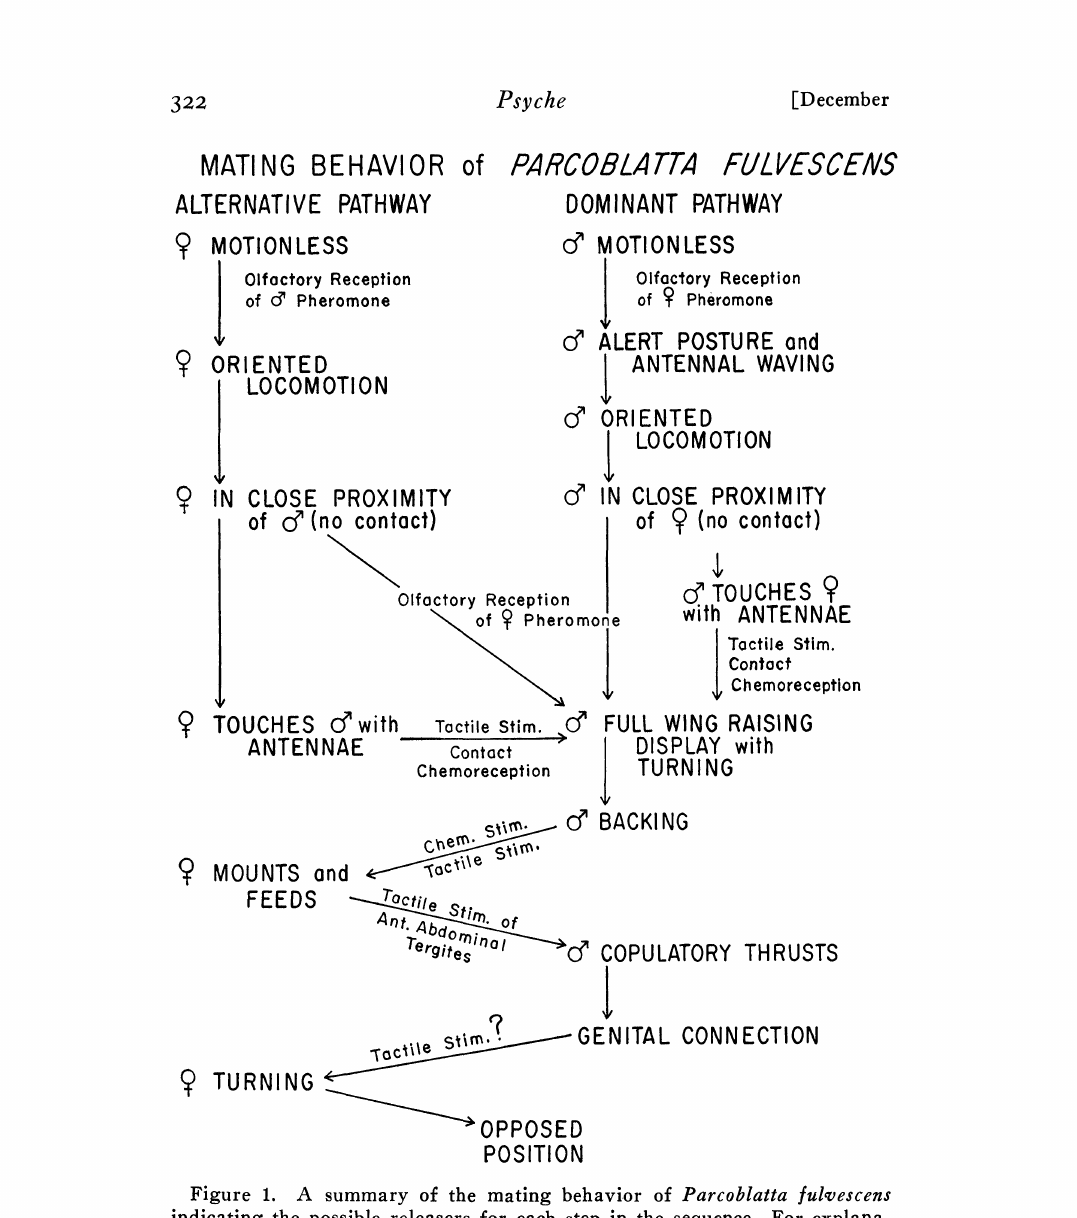
Figure 1. A summary o the mating behavior o Parcoblatta fulu;escens indicating the possible releasers or each step in the sequence. For explana- tion of alternative pathways, see